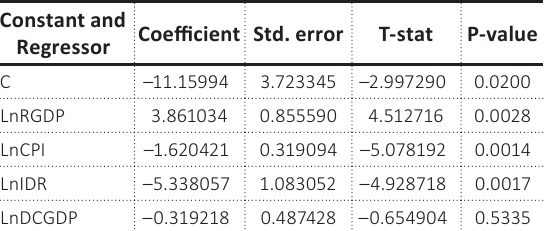
Table 4. The long-run estimation model